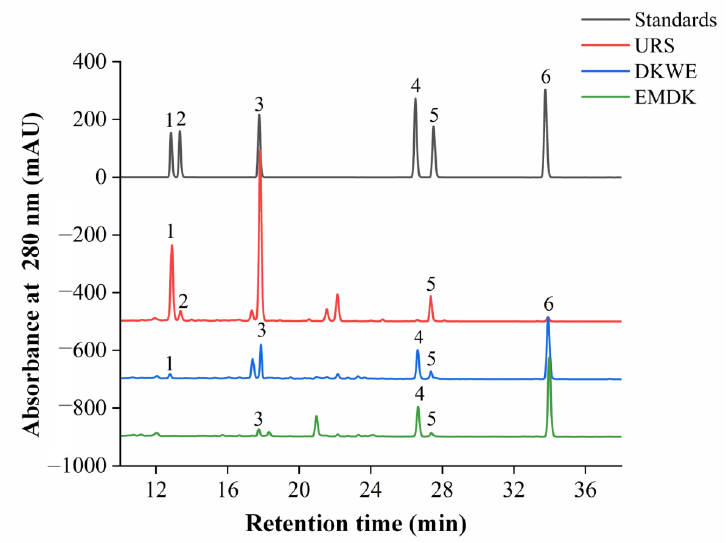
Figure 5. The HPLC chromatograms of standards and different samples at 280 nm. Abbreviations: URS, unfermented raw samples; EMDK, edible mushroom by-product Douchi koji; DKWE, Douchi koji without edible mushroom by-product. The labeled number represents the compound: 1, daidzin; 2, glycitin; 3, genistin; 4, daidzein; 5, glycitein; and 6, genistein. Table 4. The contents of isoflavones (μg/g dry matter).